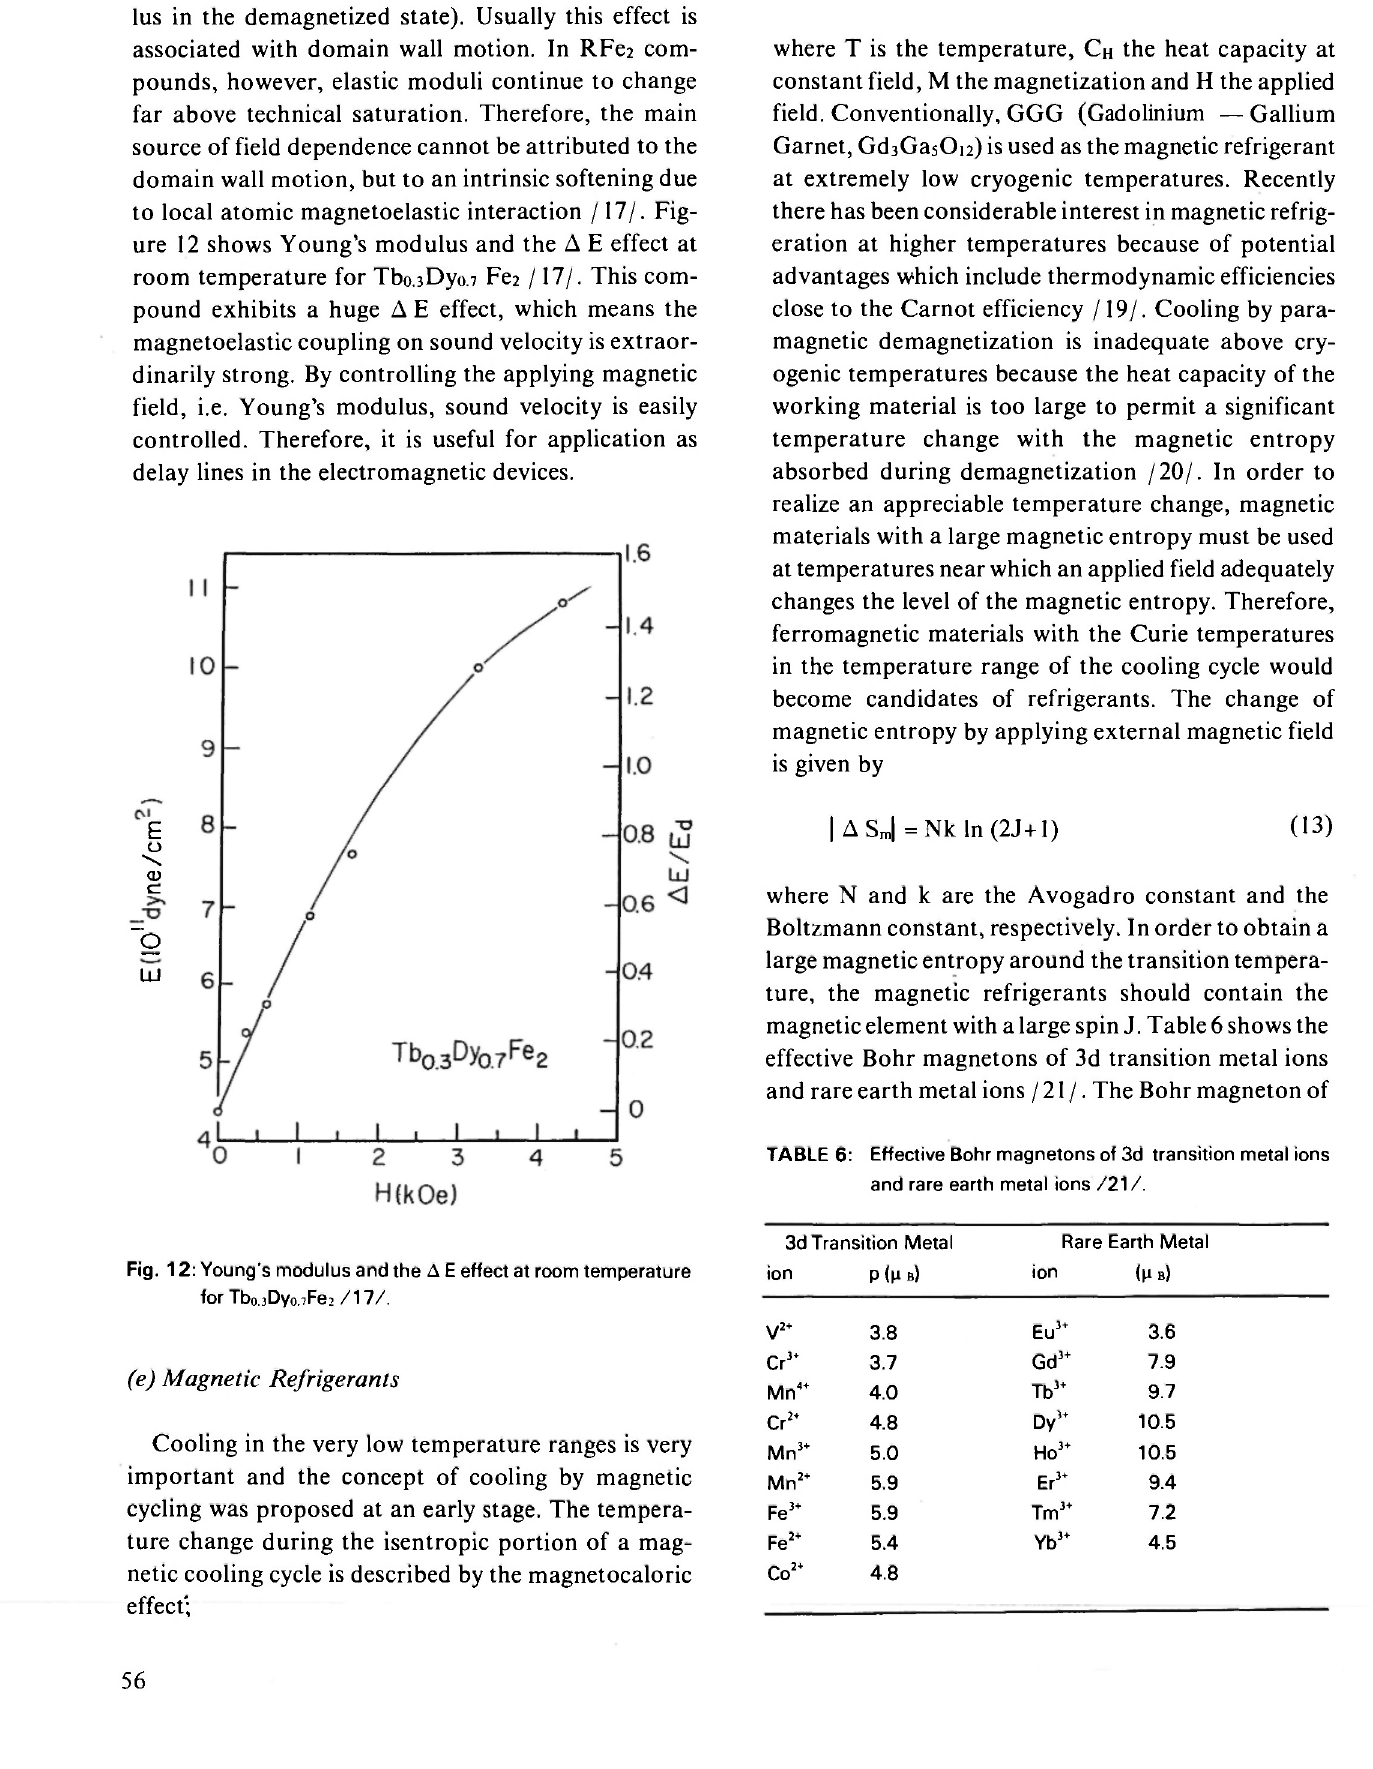
TABLE 6: Effective Bohr magnetons of 3d transition metal ions and rare earth metal ions